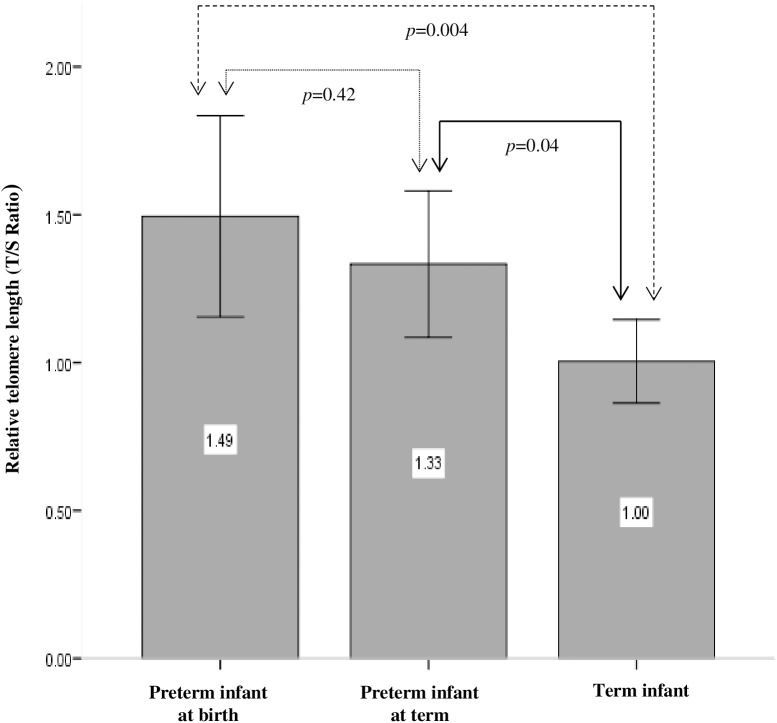
Relative telomere length (T/S ratio) in preterm infants at birth, preterm infants at term age and term born infants.Data are Mean (95% CI).